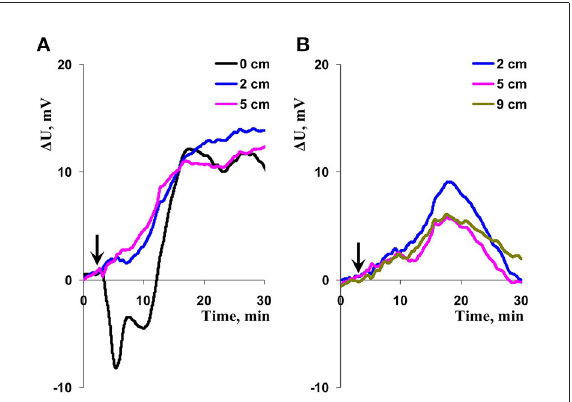
FIGURE2 Records of changes in the surface potential ( 1 U) induced by action of combination of local illumination and heating on wheat plants. (A) Extracellular measuring electrodes contacted to the second wheat leaf on border of the irritated zone (0cm) and to this leaf on 2 and 5cm from this zone ( n = 10). (B) The extracellular measuring electrodes contacted to second wheat leaf on 2, 5, and 9cm from the irritated zone ( n = 17). Combination of the blue light (540 µ mol m − 2 s − 1 ) and heating (40 ◦ C) locally acted the top of the second wheat leaf; initiation of this action is marked by arrow.